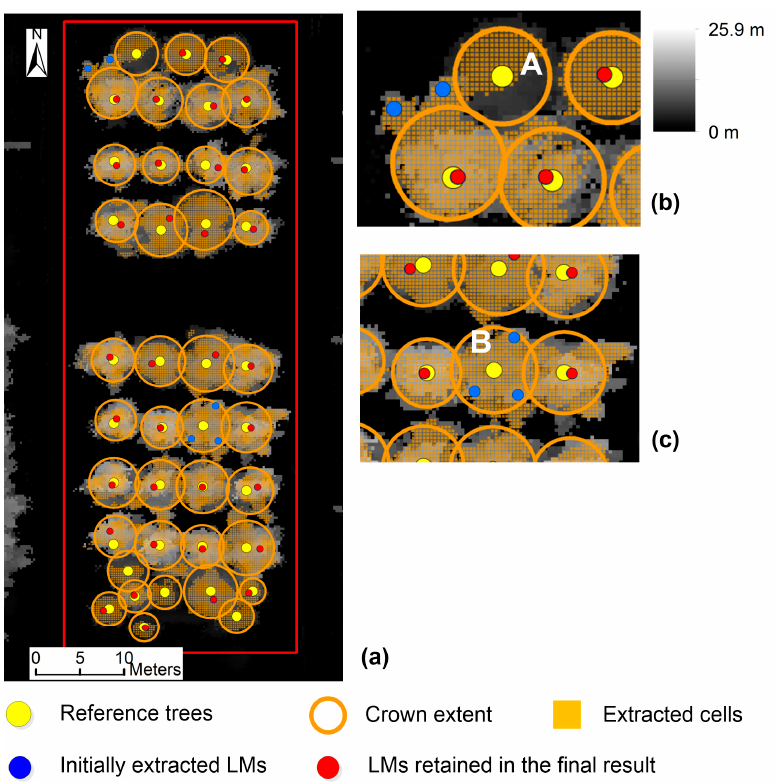
Figure 18. Tree detection result on test site 2 using the proposed approach. ( a ) Whole extent of test site 2; ( b , c ) Enlarged samples. The cells extracted through significance tests are shown in orange color. The CHM resolution is 0.25 m, the Gaussian filter size is 5 × 5, σ is 0.25 m, the LM filter size is 11 × 11, the maxD is 1.5 m, and the significance level is 0.10. The result was unaffected by the variation in score threshold.